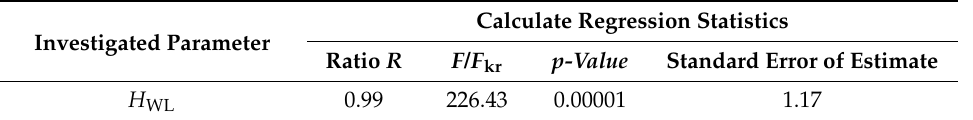
Table 5. Regression summary.